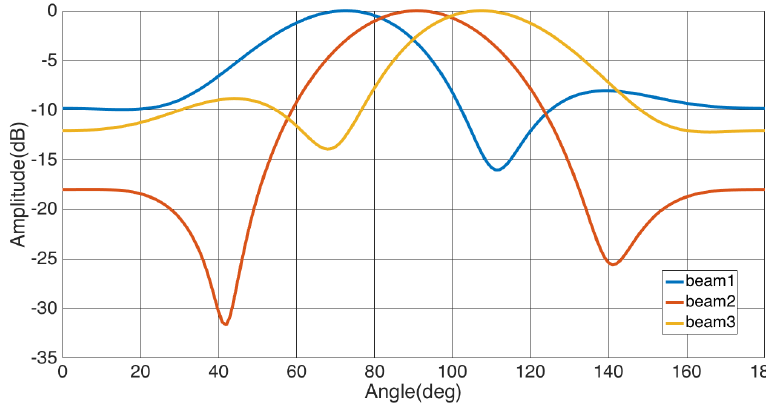
Figure 25. Calculated array factor radiation pattern when the outputs of the proposed Rotman lens (Figure 11) are used to excite the phased